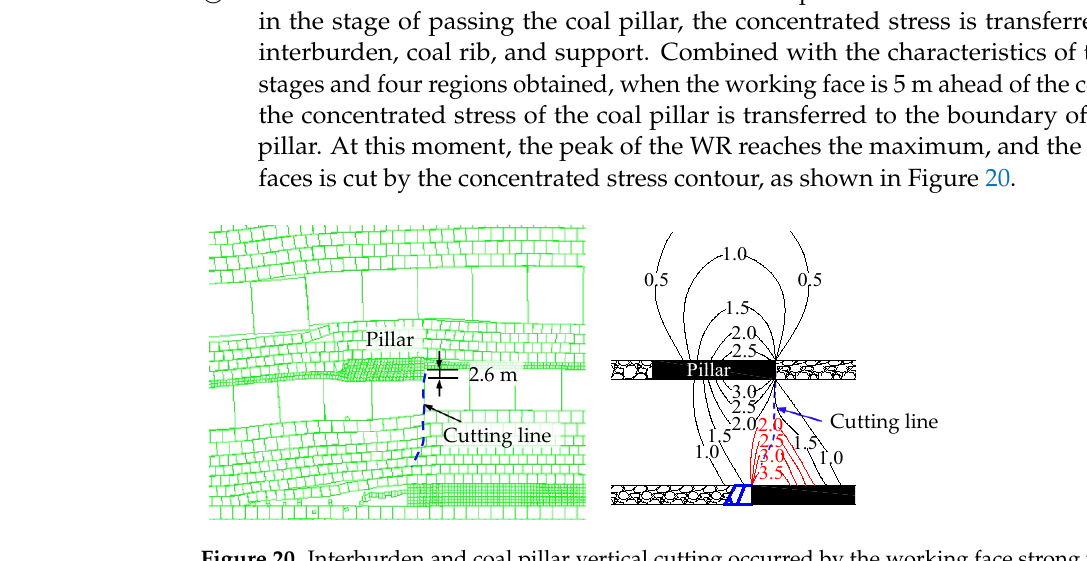
Figure 20. Interburden and coal pillar vertical cutting occurred by the working face strong weighing.